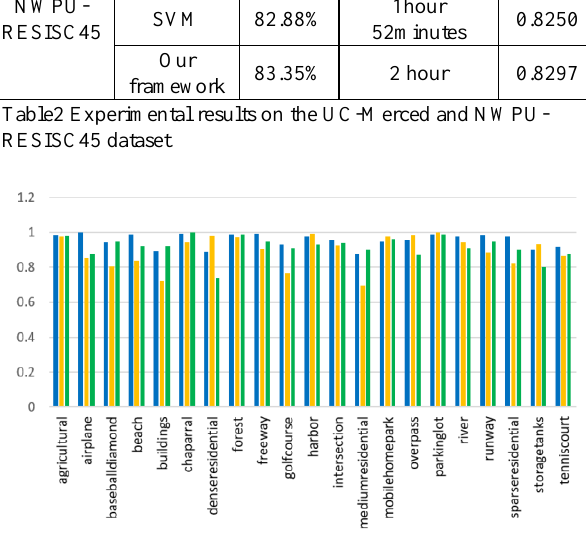
Figure 6 Comparison of the classification accuracy of each class of the three methods on the UC-Mercerd dataset. Blue represents our framework. Yellow represents the VGG16 model. Green represents the SVM.